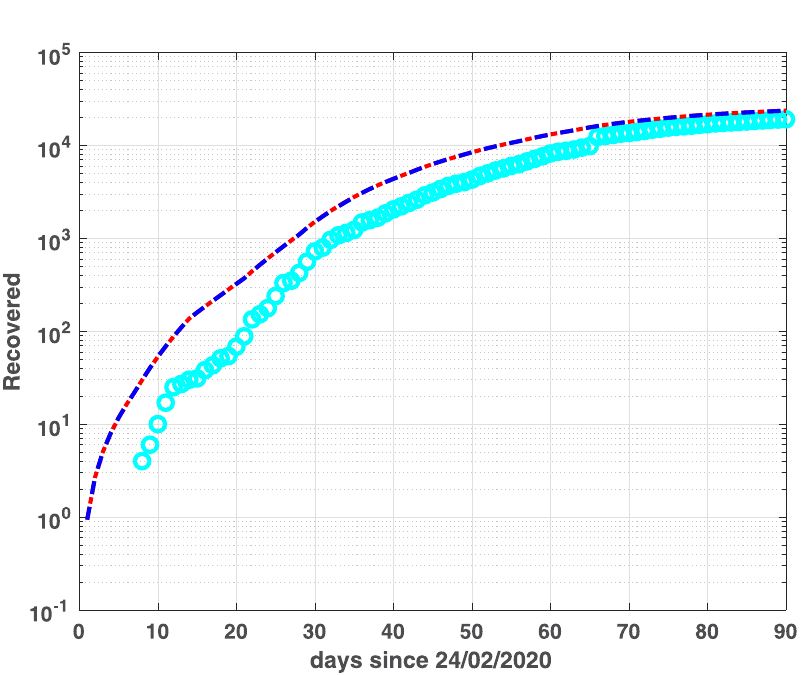
Fig 5. Recovered compartments for Emilia-Romagna. Recovered data (cyan dots) and Recovered modelled population, obtained by fSEIRDr (blue dash-dotted line) and fSEIDRe (red continuous line).